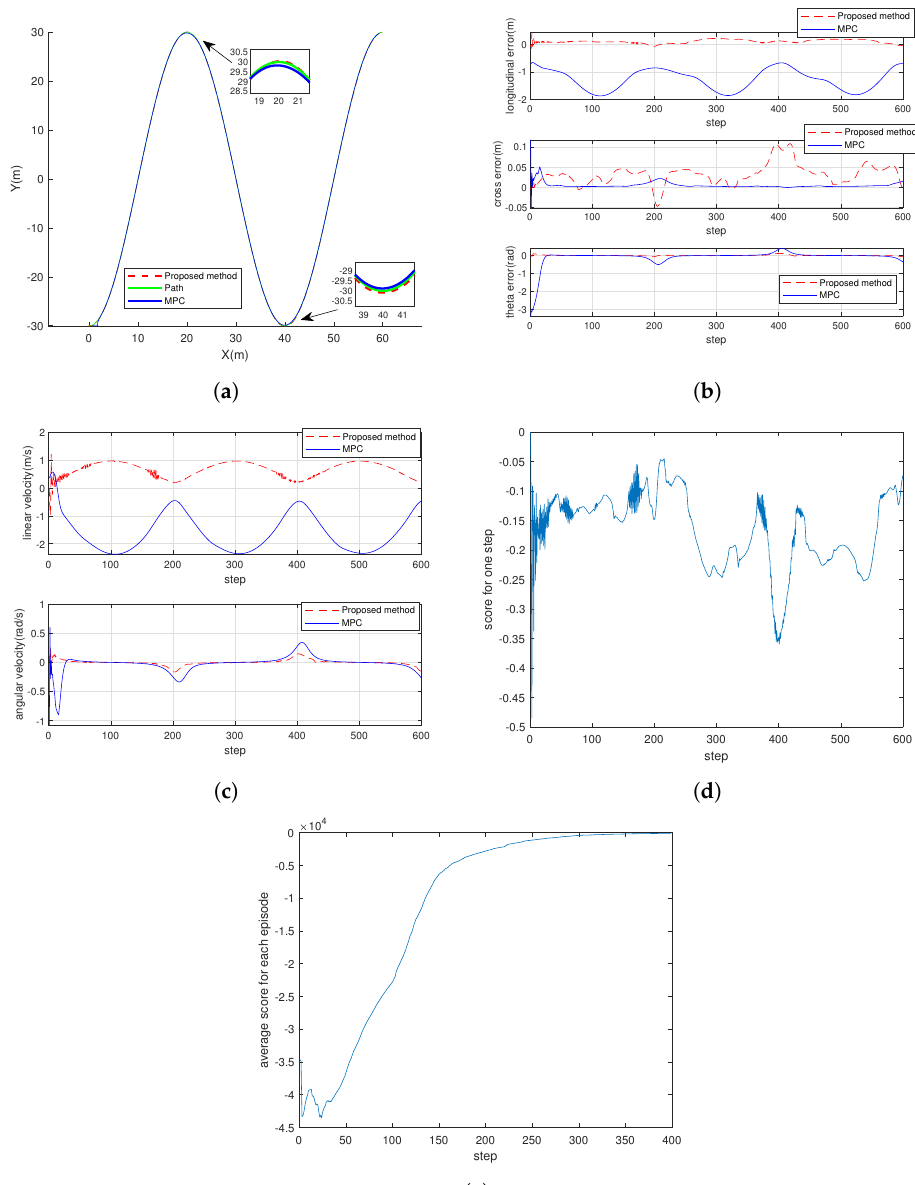
Figure 5. Comparisons of proposed method and MPC for performance of path-following con- trol. ( a ) Comparison of paths for following. ( b ) Errors in path-following. ( c ) Inputs for path- following. ( d ) Scoring of each step with proposed method. ( e ) Average scoring for each episode with proposed